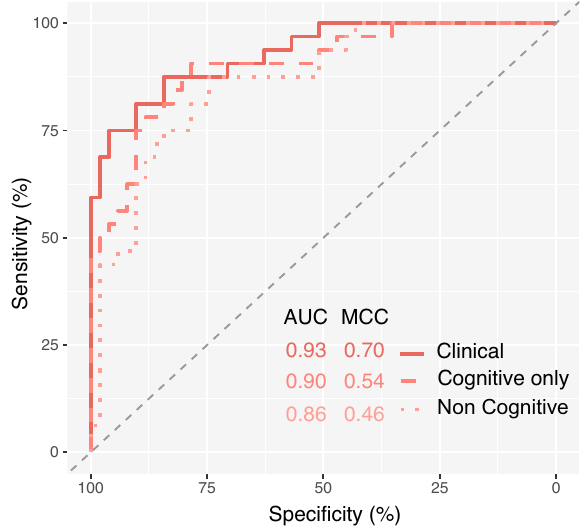
Fig. 4 Sensitivity analysis of cognitive variables. ROC showing prediction of the cognitive impairment outcome using Cforest applied on clinical subsets. Noncognitive variables: dotted line, cognitive variables: dashed line, all clinical variables: solid line. Summary of AUC and MCC metrics for each subset shown in plot text. AUC area under the curve, MCC Matthews Correlation Coef fi cient, Cforest Conditional Inference Random Forest, ROC receiver operating